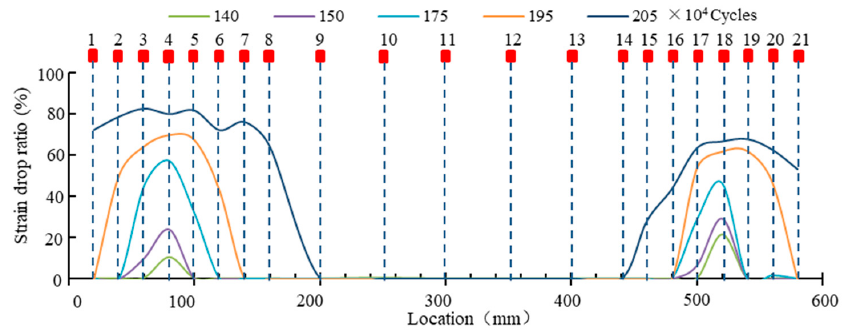
Figure 6. Strain drops measured in TEU-10.